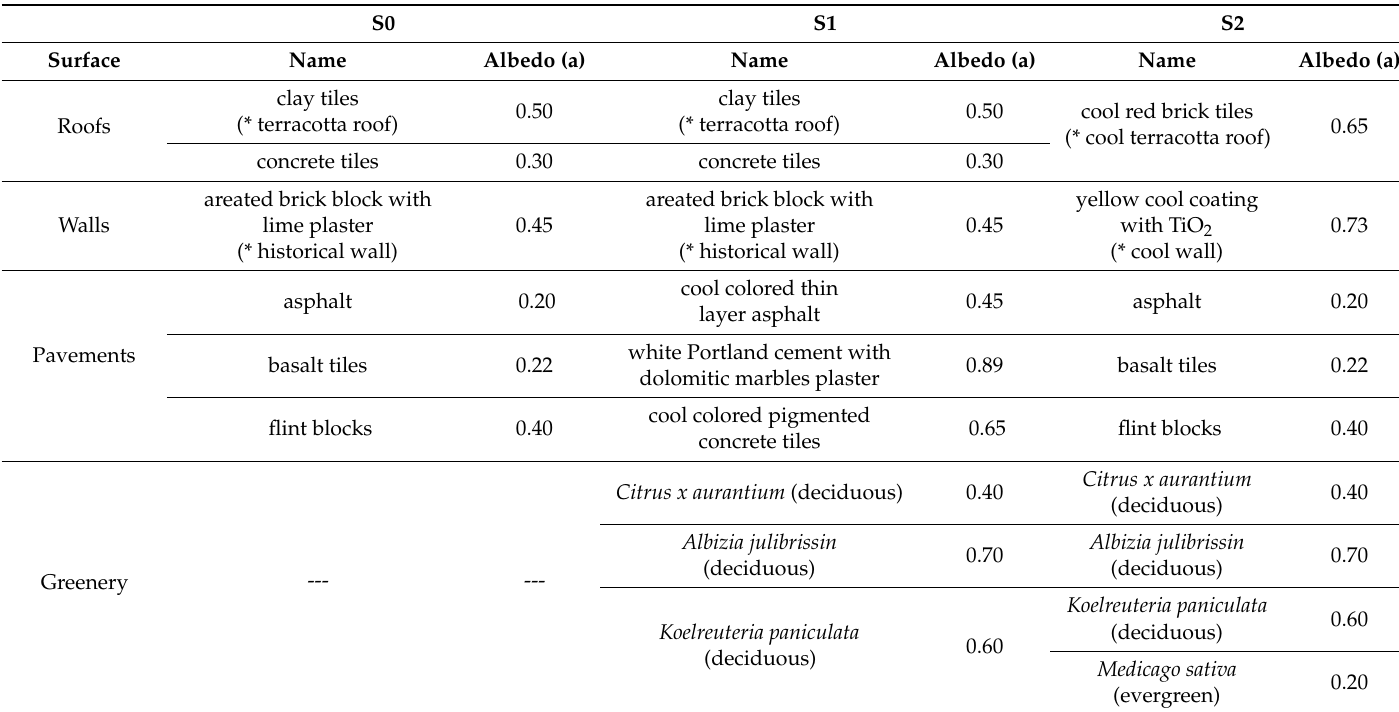
Table 1. Materials’ database of the analyzed scenarios: S0 initial condition, S1 first renovation scenario (cool pavements + trees), second renovation scenario (cool roofs + cool walls + trees + grass).